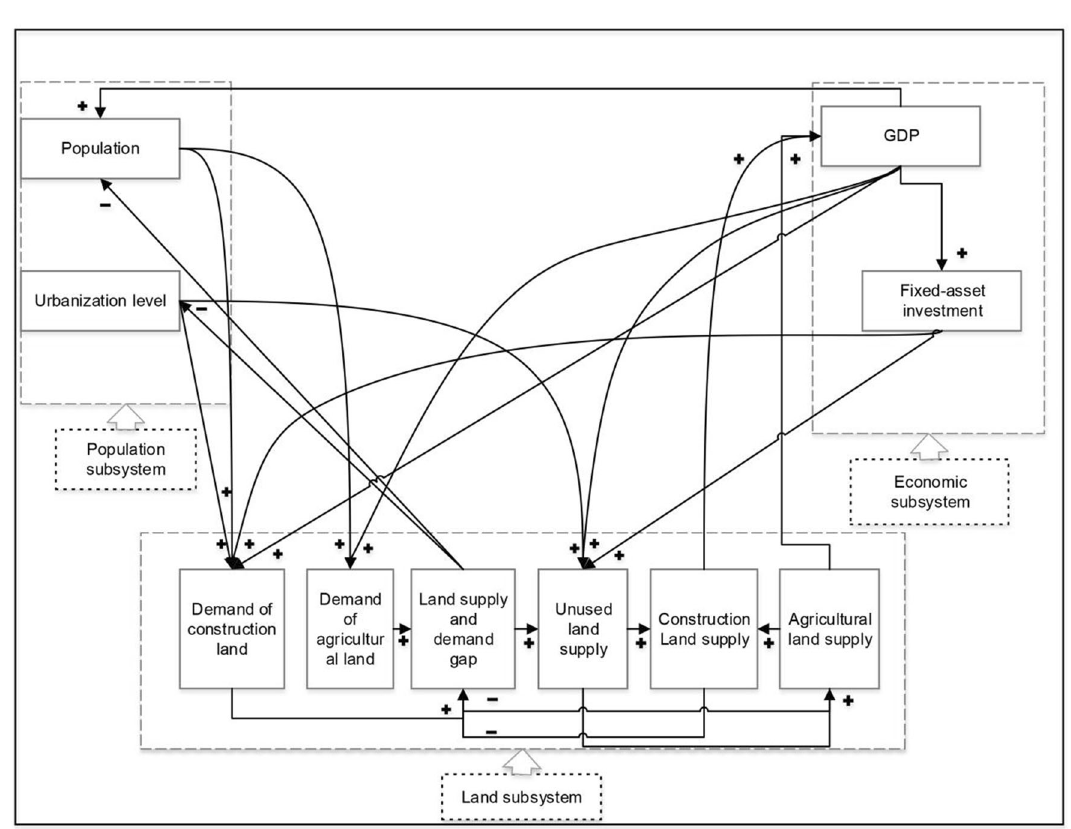
Fig. 2 Cause-and-effect feedback diagram of system dynamic model of land use system in